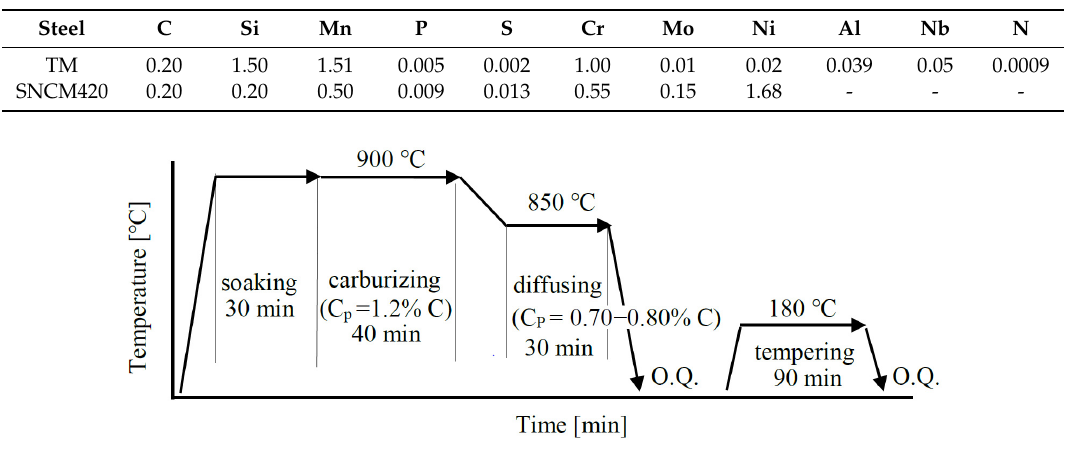
Table 1. Chemical composition [mass %] of the steels used in this study. TM: TRIP-aided martensitic.